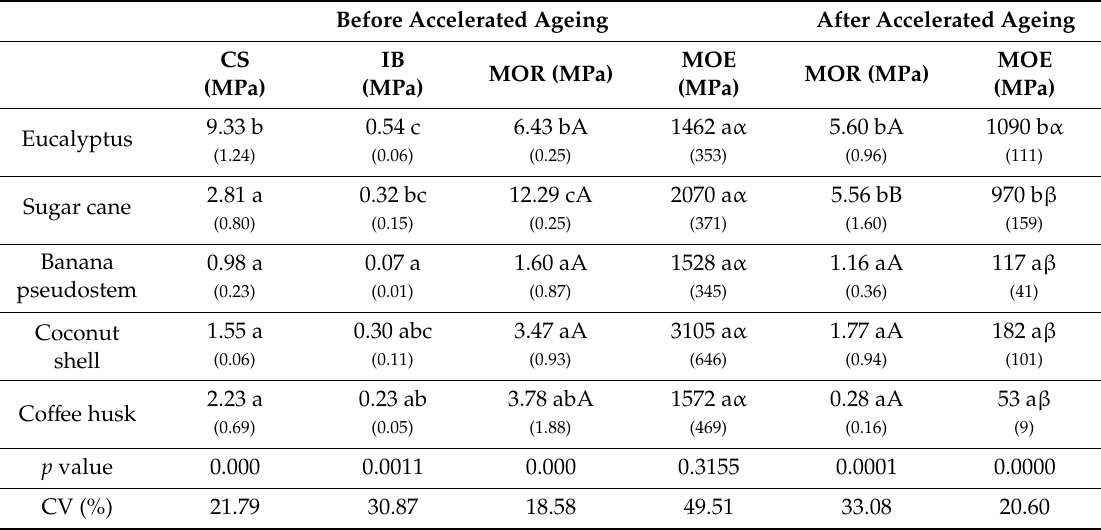
Table 4. Compression strength (CS), internal bonding (IB), modulus of rupture (MOR), and modulus of elasticity (MOE) of the lignocellulosic composites before and after the accelerated ageing process. Before Accelerated Ageing After Accelerated